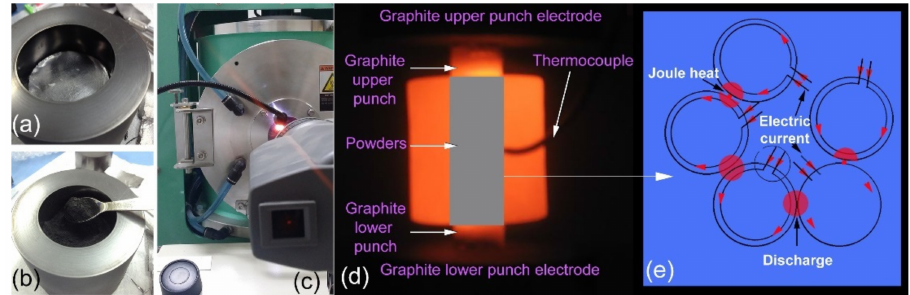
Figure 10. A 50 mm graphite die ( a ) before and ( b ) after charging with metallic glassy (Zr 70 Ni 25 Al 5 ) 65 W 35 powders. The die charged with the powders was mounted inside the SPS unit, where the temperature was monitored by a pyrometer ( c ). A photo of the die during the SPS process is displayed in ( d ). The ON-OFF DC pulsed current route and pulsed current flow via powder particles in the graphite die during the SPS process are shown schematically in ( e